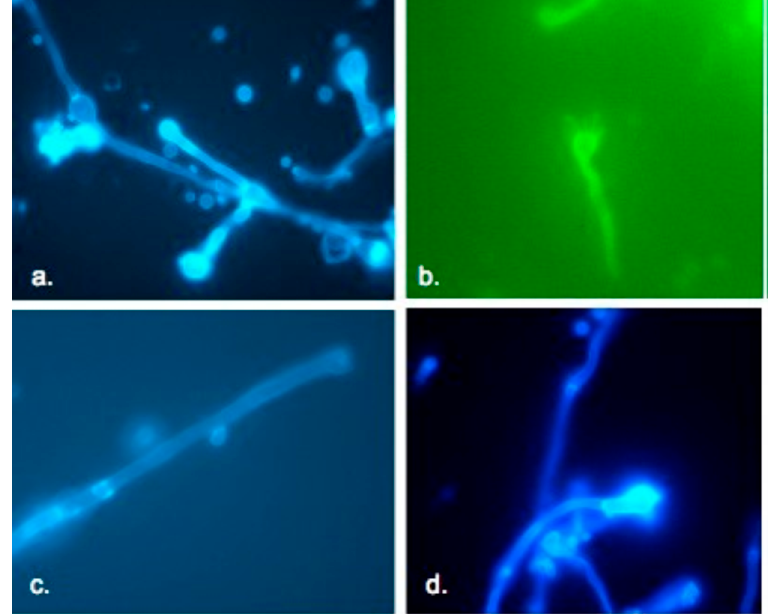
Figure 3. Sexual structures of Cryptococcus gattii VGII isolates that mated with an opposite mating type strain. ( a ) Presence of basidia resulting from the mating of C. gattii VGIIa (MAT α ) strain with JEC20 ( Cryptococcus neoformans serotype D, MATa); ( b ) formation and detachment of basidiospores from basidium resulting from the mating of C. gattii strain H0058-I-357 (MATa) with JEC21 ( C. neoformans serotype D, MAT α ); ( c ) hyphae with the presence of fibule junction; and ( d ) formation of basidiospores from a basidium resulting from the mating of C. gattii VGIIb (MAT α ) strain with JEC20 (MATa). All preparations were done with calcofluor (1 mg / mL) and observed at a wavelength of 425 nm, 40 × .